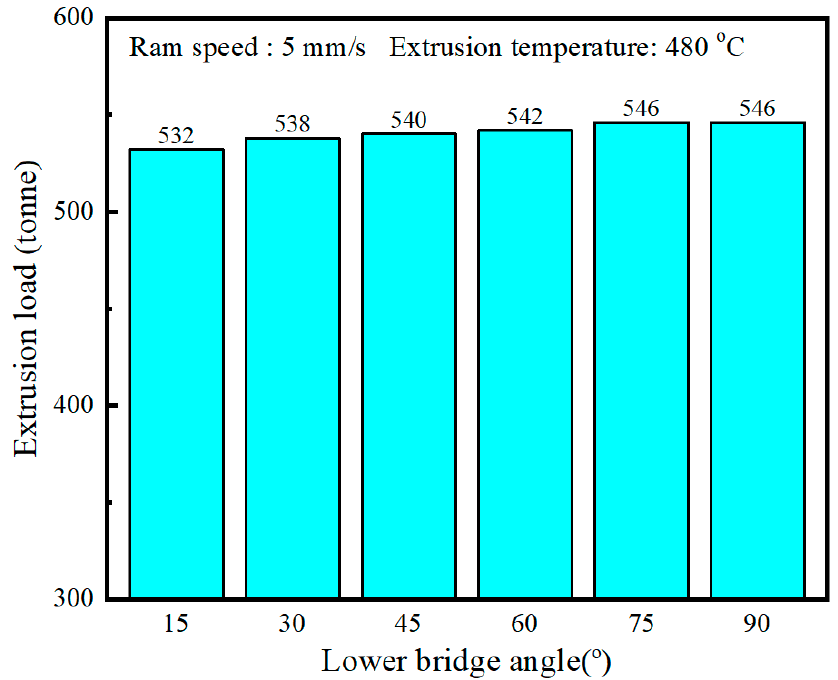
Figure 6. Model-predicted extrusion load versus lower bridge angle.